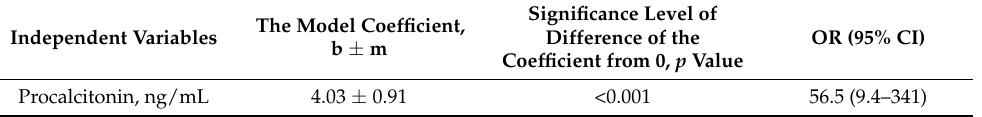
Table 5. Analysis of risk of death in a single-factor logistic regression model for the Delta group.